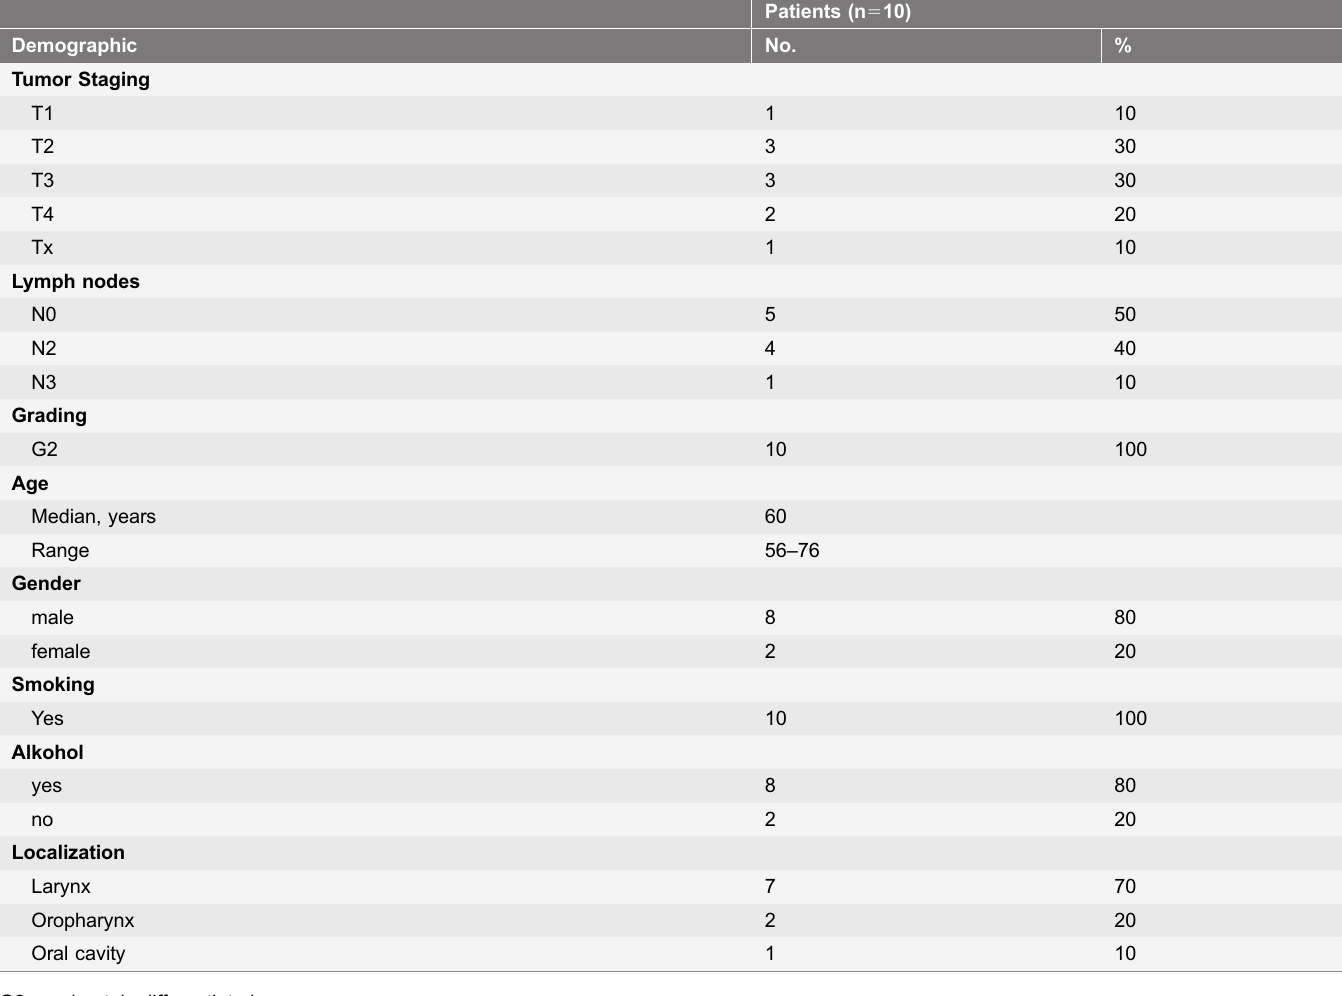
Table 1. Patients